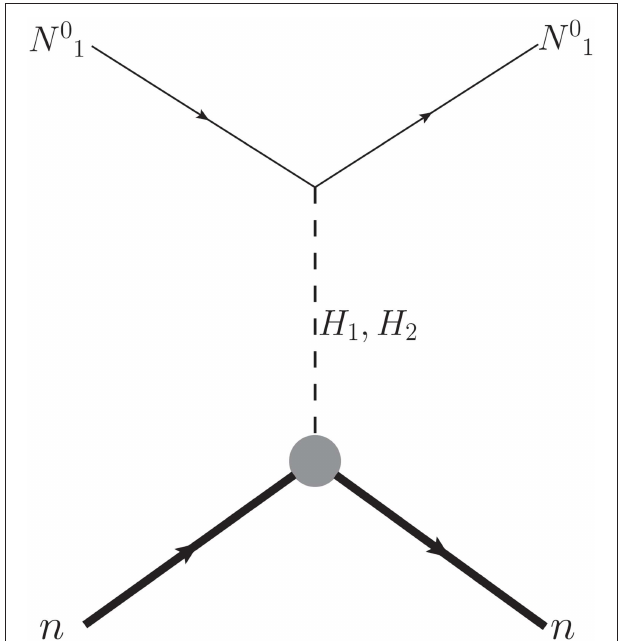
FIGURE 12 | Elastic scattering of the ILD DM( N 0 ) with the nucleon through scalar mediation due to doublet triplet mixing.